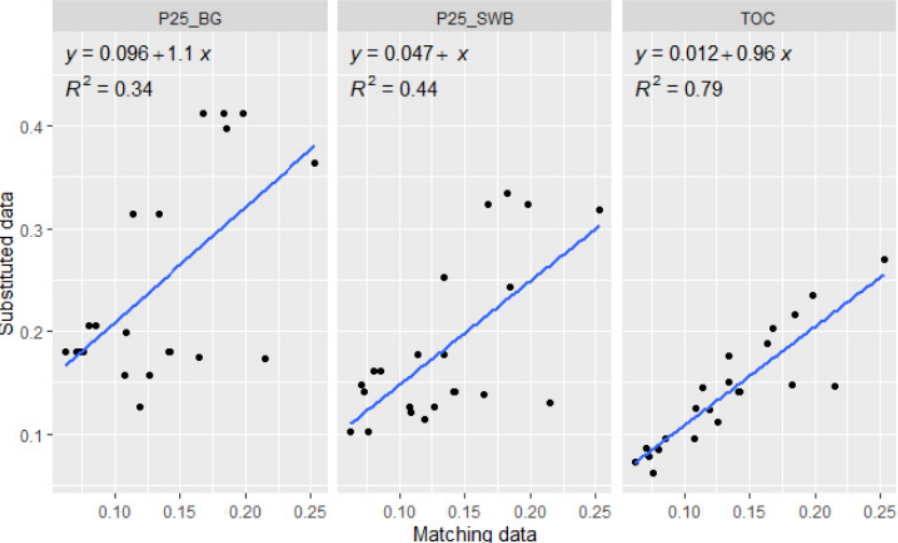
Figure 10. The comparison of the BIO-MET calculated RCR for Pb between the matching data and substituted data (P25_BG—the 25th percentile of the available DOC data and/or the DOC data calculated by the TOC from the Bulgarian monitoring network results during 2020; P25_SWB—the 25th percentile of the DOC data calculated by the TOC for the respective water body; TOC—the matching DOC data calculated by TOC).